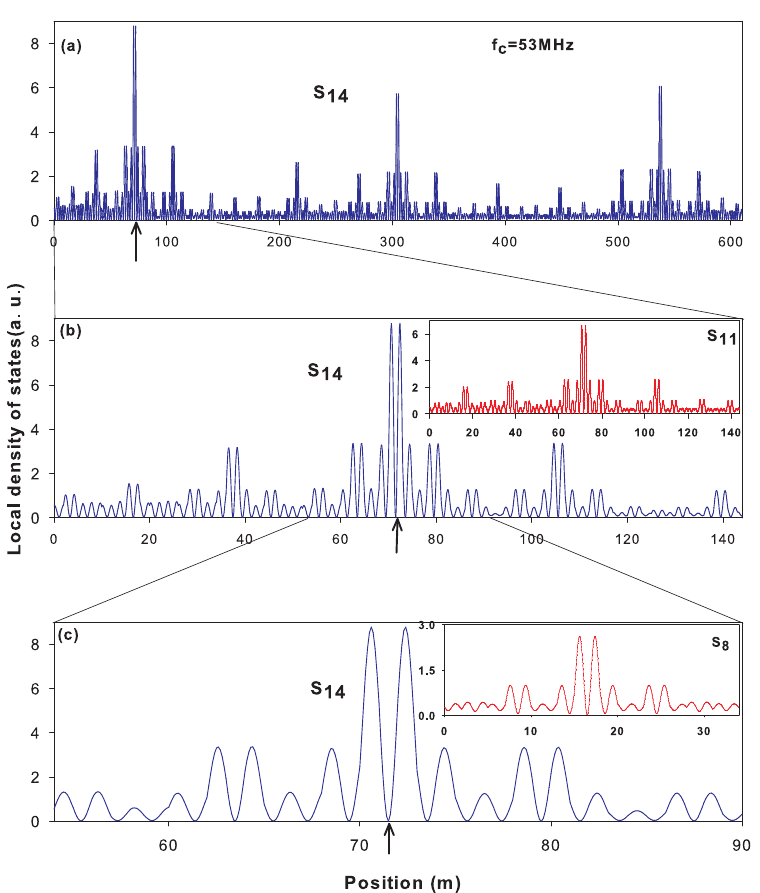
Figure 4. ( a – c ) Represent the spatial representation of the local density of states (LDOS) [in arbitrary units] of the mode lying at the central frequency f c = 53 MHz for the 14th generation. The insets of ( b , c ) correspond to the LDOS associated with the 11th and 8th generations at f c ,